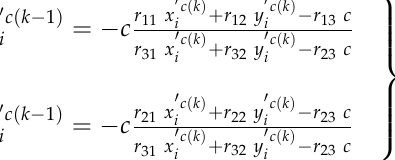
Figure 13. Sample exhaustive matching results with several outliers for a stereo-pair in the US-231 dataset (for a better visualization only 10% of matches are illustrated).